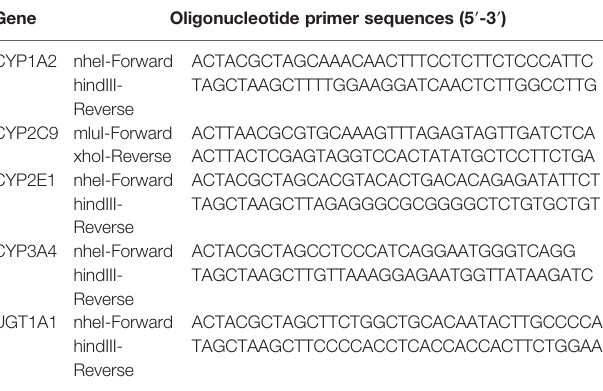
TABLE 3 | Primers used for vector